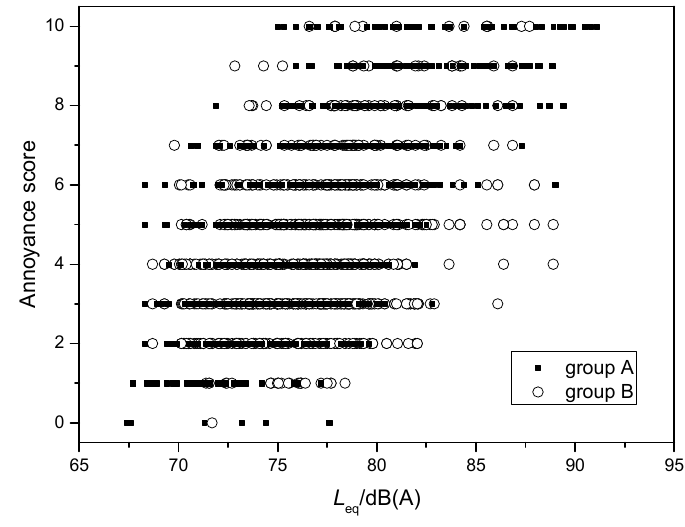
Figure 11. Comparison of all equivalent SPLs and annoyance scores. To observe and describe the relationship between annoyance and SPL better, samples were averaged and fitted with the logistic function. First, the range of SPL values was divided into 19 sections with an interval of 1 dB(A). Both the annoyance scores and SPL values in each section were averaged, as illustrated in Figure 12 using red solid dots. In Figure 12, analyses of the samples for the two groups, group A only, and group B only are shown.